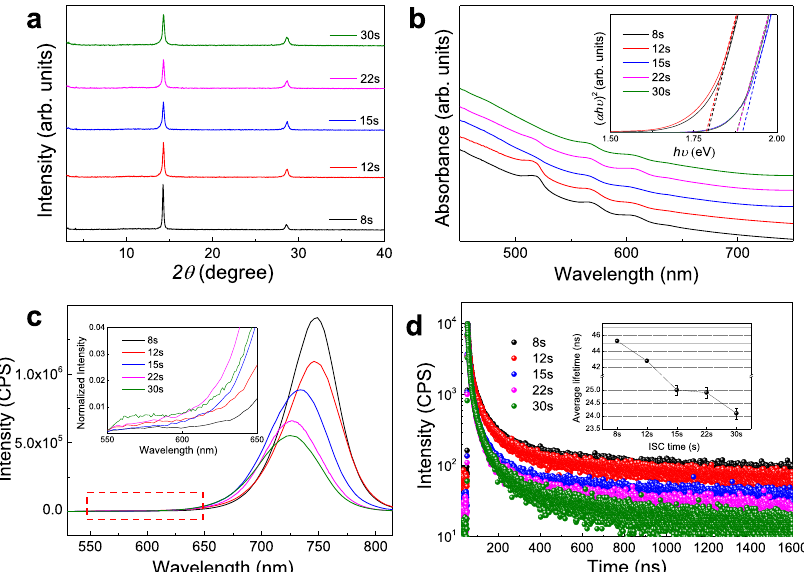
Fig. 2 Evolution of crystallinity and phase compositions. PEA 2 MA 3 Pb 4 I 13 thin fi lms fabricated with various ISC times: a XRD patterns and b optical absorption spectra with an inset of tauc plots (both are vertically shifted and rescaled for clarity). c Steady-state PL spectra with an inset of magni fi cation between 550 and 650 nm, and d TRPL kinetics with an inset of derived average lifetimes with standard deviations from three independent fi lms. Thereafter, the black, red, blue, magenta and olive lines (or symbols) represent the ISC-8s, 12 s, 15 s, 22 s and 30 s samples, respectively, unless otherwise